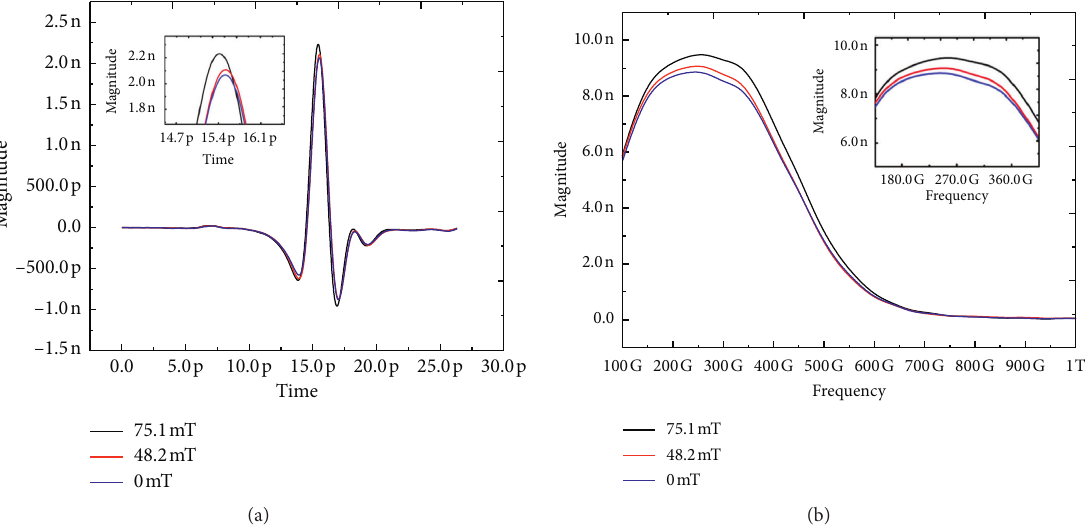
Figure 7: Time domain spectrum (a) and frequency domain spectrum (b) of magnetic fluid under different magnetic